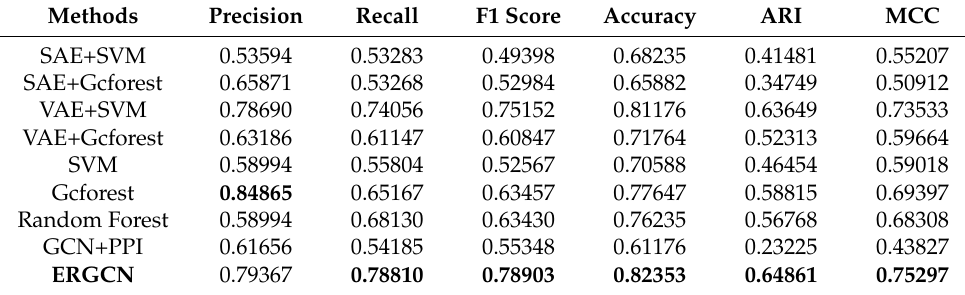
Table 7. The experiment results for a new sample on LUNG